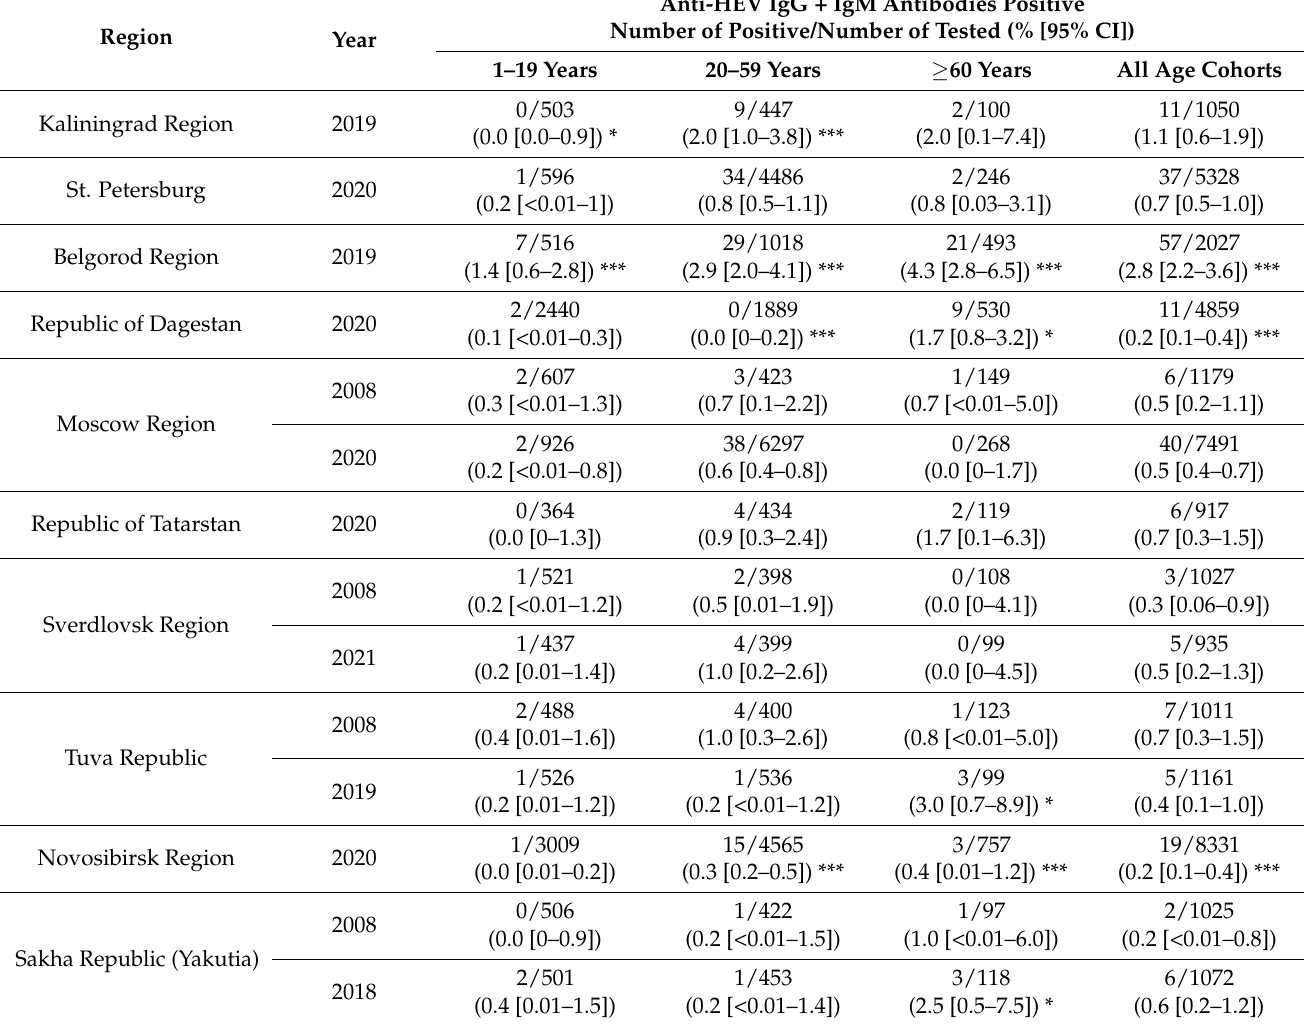
Table 1. Proportion of study participants reactive for both anti-HEV IgG and IgM